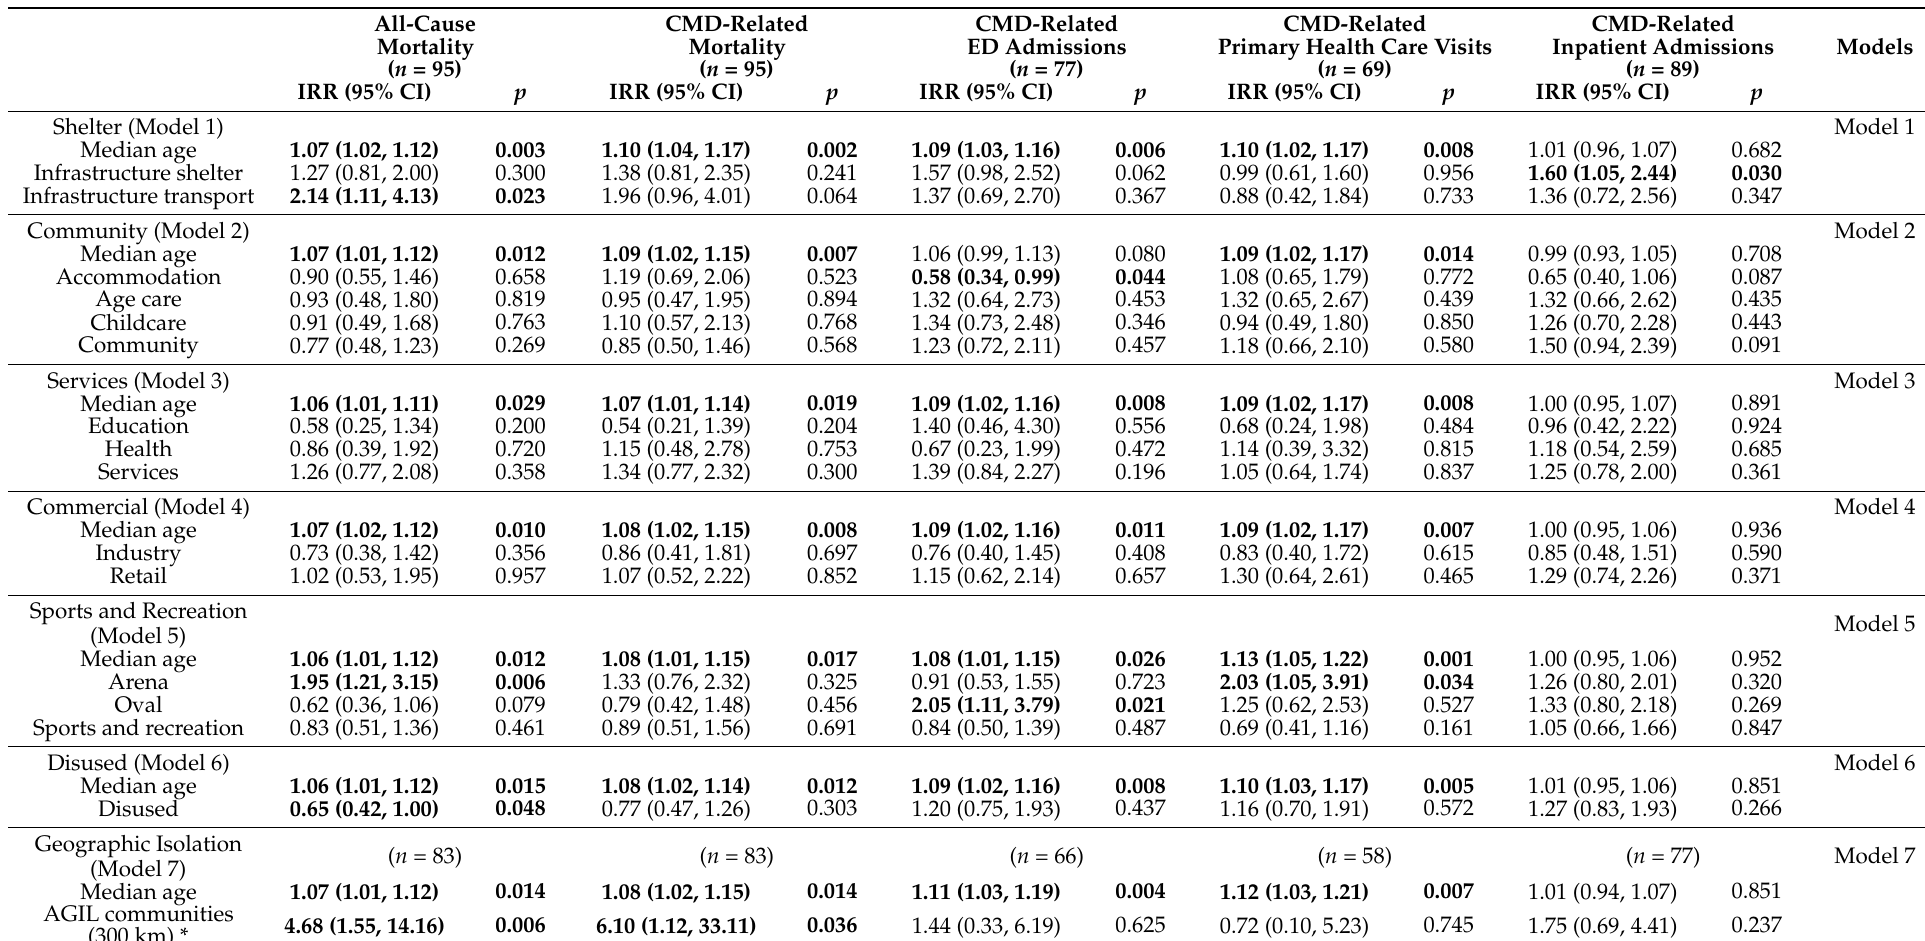
Table 3. Multivariable regression of built environment features by domain on all-cause mortality and cardiometabolic-related mortality and morbidity, adjusting for median age of ILOC